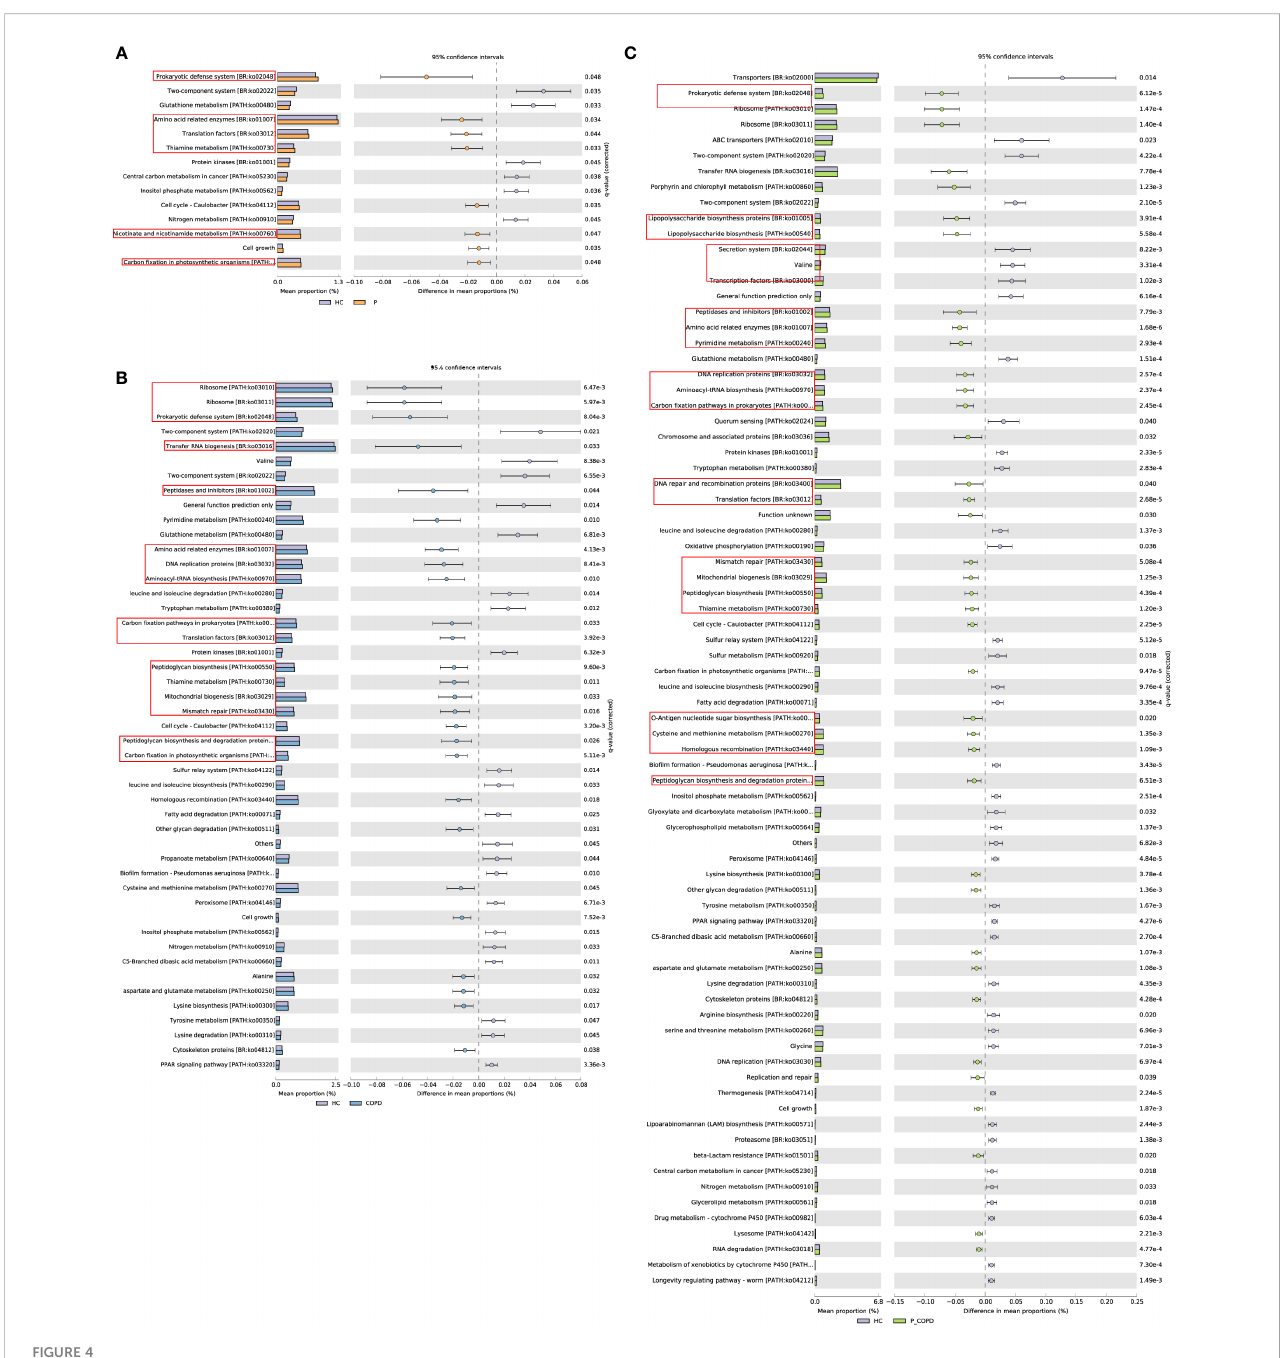
FIGURE 4 PICRUSt analysis in the KEGG pathways. Functional predictions for the oral microbiome of the diseased groups and healthy control group. Signi fi cant KEGG pathways at level 3 for the oral microbiome of the diseased groups and healthy control group in subgingival plaque samples were identi fi ed by STAMP software. Bar chart showing the functional difference (corrected p -value < 0.05) between periodontitis (A) , chronic obstructive pulmonary disease (B) and comorbid diseases (C) versus healthy controls. PICRUSt, Phylogenetic Investigation of Communities by Reconstruction of Unobserved States; KEGG, Kyoto Encyclopedia of Genes and